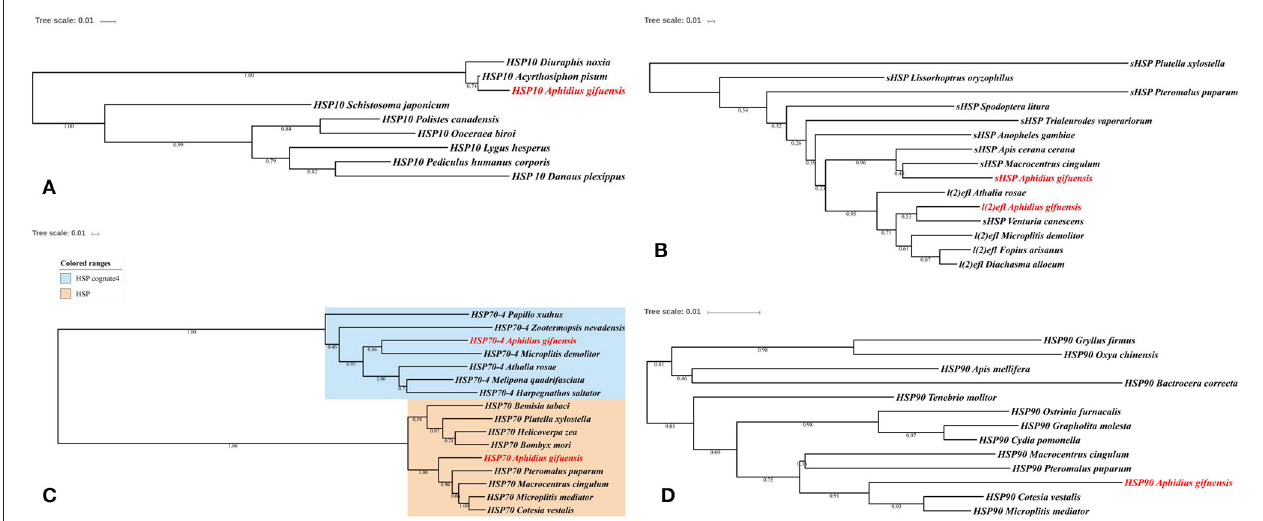
FIGURE 1 | Phylogenetic analysis of HSPs in insects. (A) HSP10, (B) sHSP, (C) HSP70, and (D) HSP90.